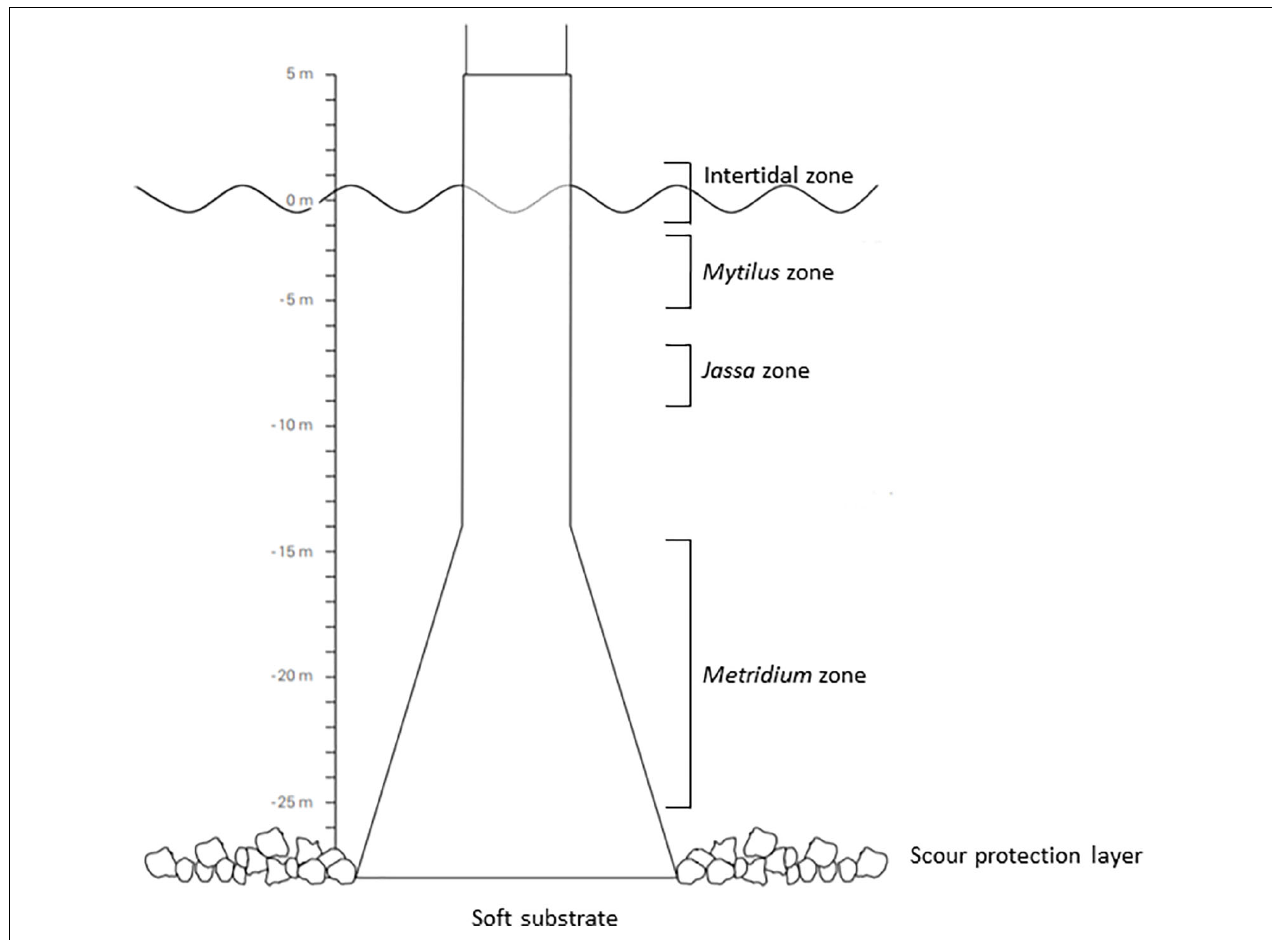
FIGURE 1 | Vertical zonation pattern based on macrofauna and structural/habitat differences along the depth gradient of an offshore wind farm gravity-based foundation (modified by the source: De Mesel et al.,